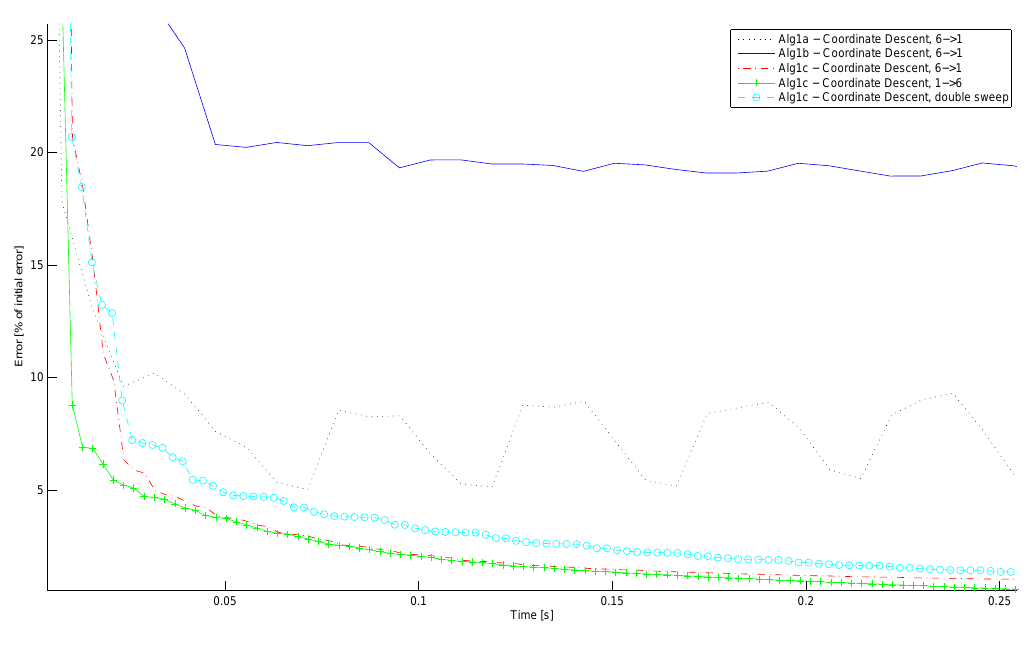
Figure 3: Convergence of Coordinate Cyclic Descent Algorithms that move one joint at the time. Initial condi- tions is set close to a